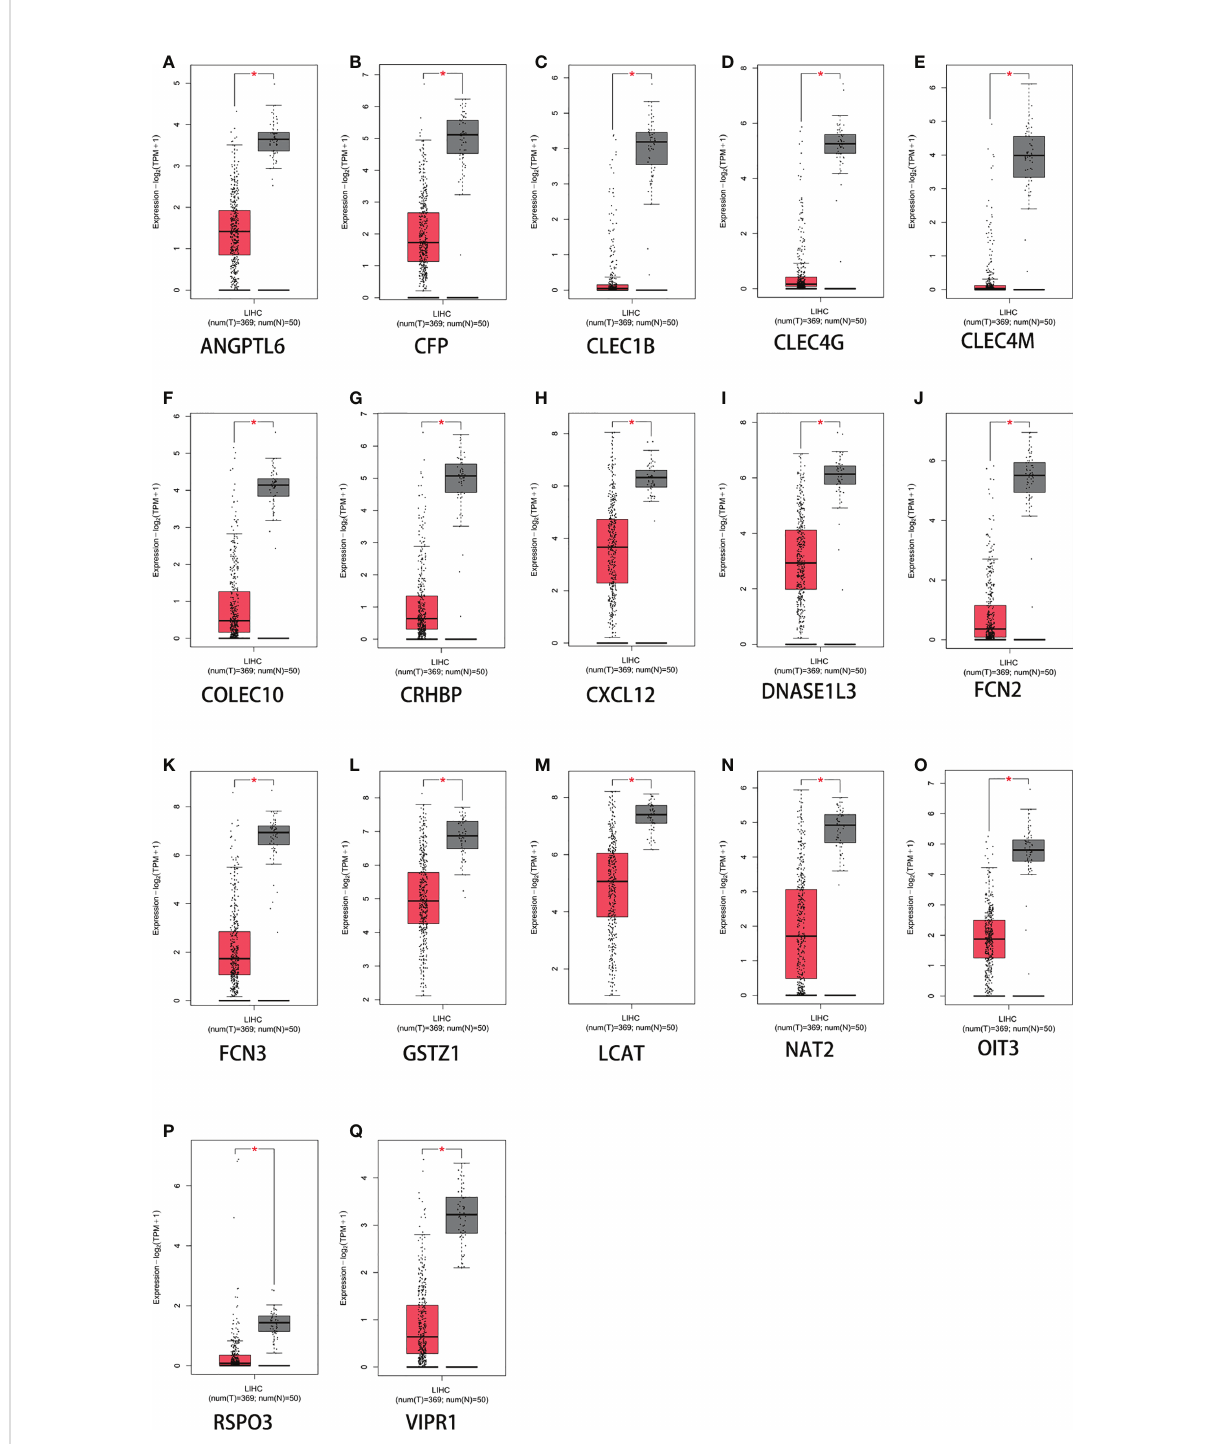
FIGURE 2 Expression levels of 17 genes based on GEPIA2 (Gene Expression Pro fi ling Interactive Analysis web server). (A) ANGPTL6 . (B) CFP . (C) CLEC1B . (D) CLEC4G . (E) CLEC4M . (F) COLEC10 . (G) CRHBP . (H) CXCL12 . (I) DNASE1L3 . (J) FCN2 . (K) FCN3 . (L) GSTZ1 . (M) LCAT . (N) NAT2 . (O) OIT3 . (P) RSPO3 . (Q) VIPR1 . * p <0.05. The y -axis represents the relative log2 expression value (TPM +